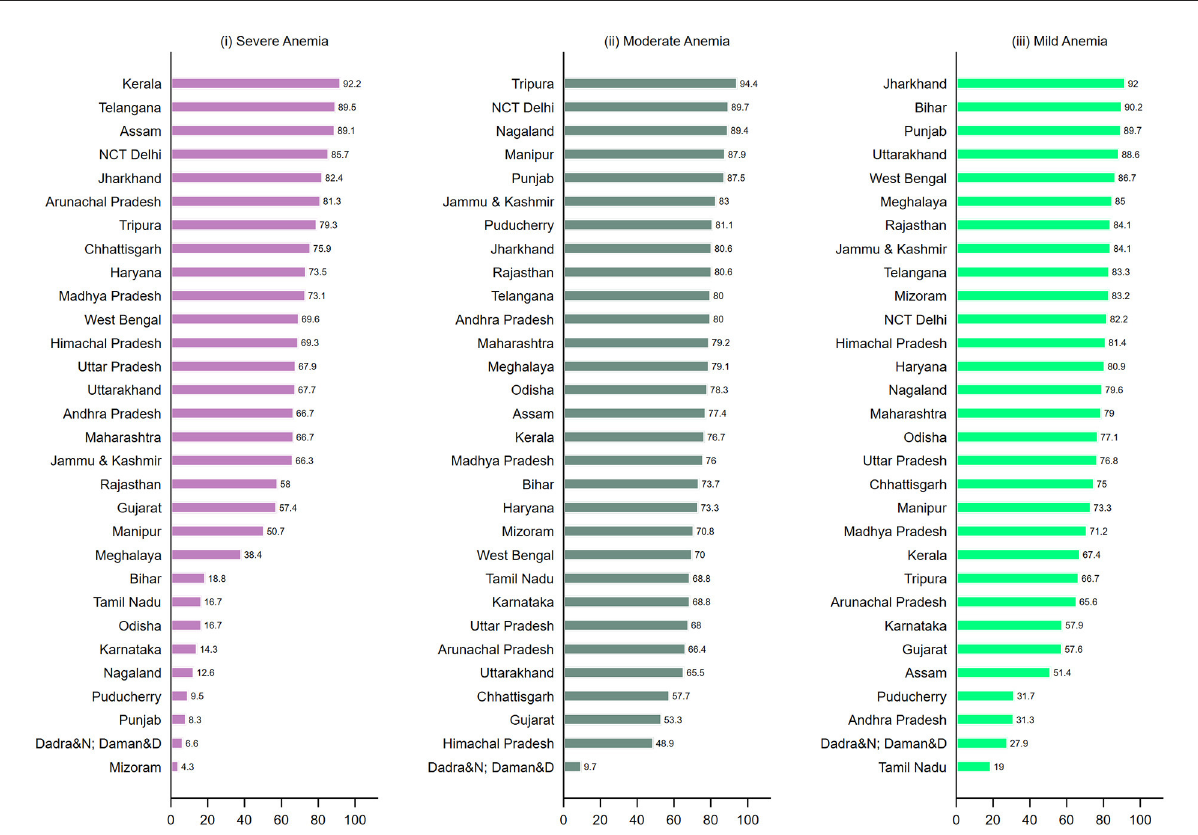
FIGURE3 Geographic variation of (i) Severe anemia; (ii) Moderate anemia; (iii) Mild anemia among women (15–49 years) attributable to small areas (cluster) (%) across states and Union Territories in India, NFHS, 2021.